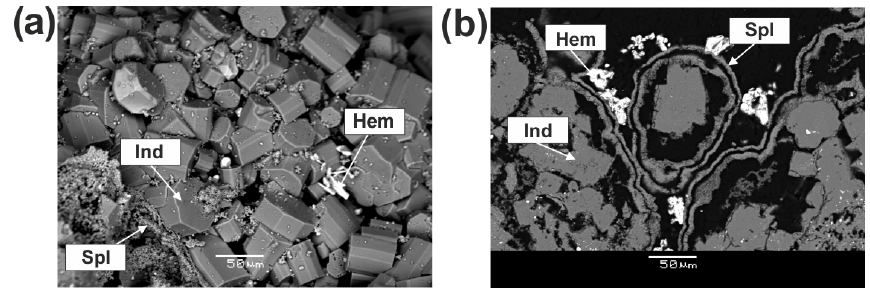
Figure 13. Crystals of indialite (Ind) overgrown by spinel (Spl) in association with hematite (Hem). Mountain 1004. BSE images.